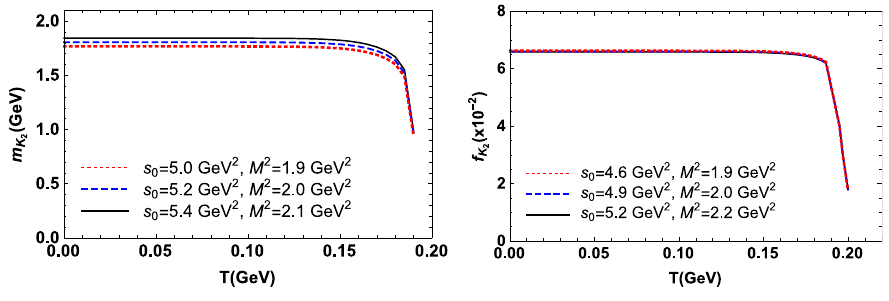
Figure 1: The thermal behavior of the mass (left) and the decay constant (right) of pseudoten- sor K 2 (1820)